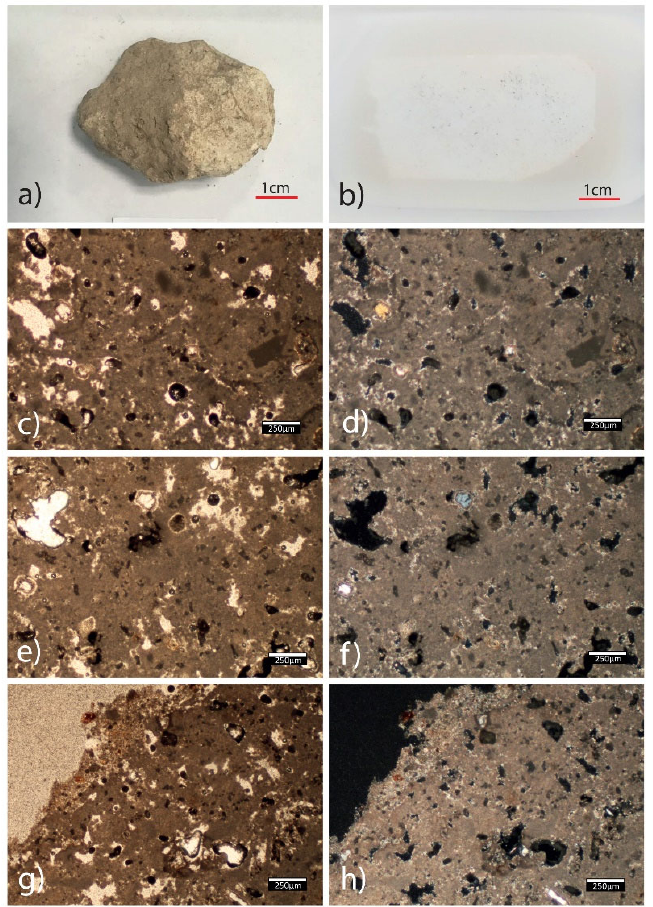
Figure 9. Sample MIN8 (Group P3) microphotographs under polarised light microscopy (PL-OM). Limestone fragments with residue of fine lime plaster. ( a ) analysed fragment; ( b ) homogeneous thin section; ( c , e ) parallel polars and ( d , f ) crossed polars: microcrystalline calcitic matrix; ( g ) parallel polars and ( h ) crossed polars: residue of fine lime plaster with quartz and cocciopesto aggregate (top left of photo).